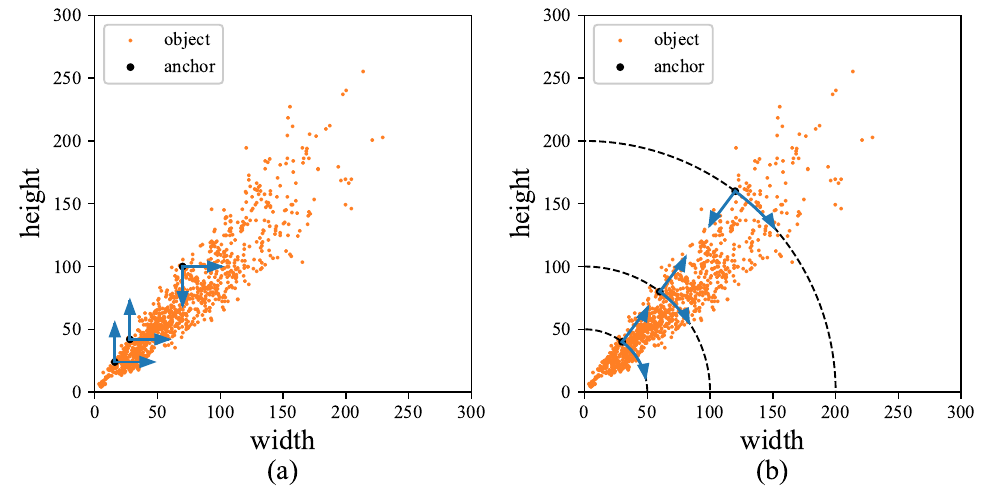
Figure 3. ( a ) In the general algorithm, anchors are obtained by calculating the width and height. ( b ) In the LAG, anchors are generated by calculating the aspect ratio and